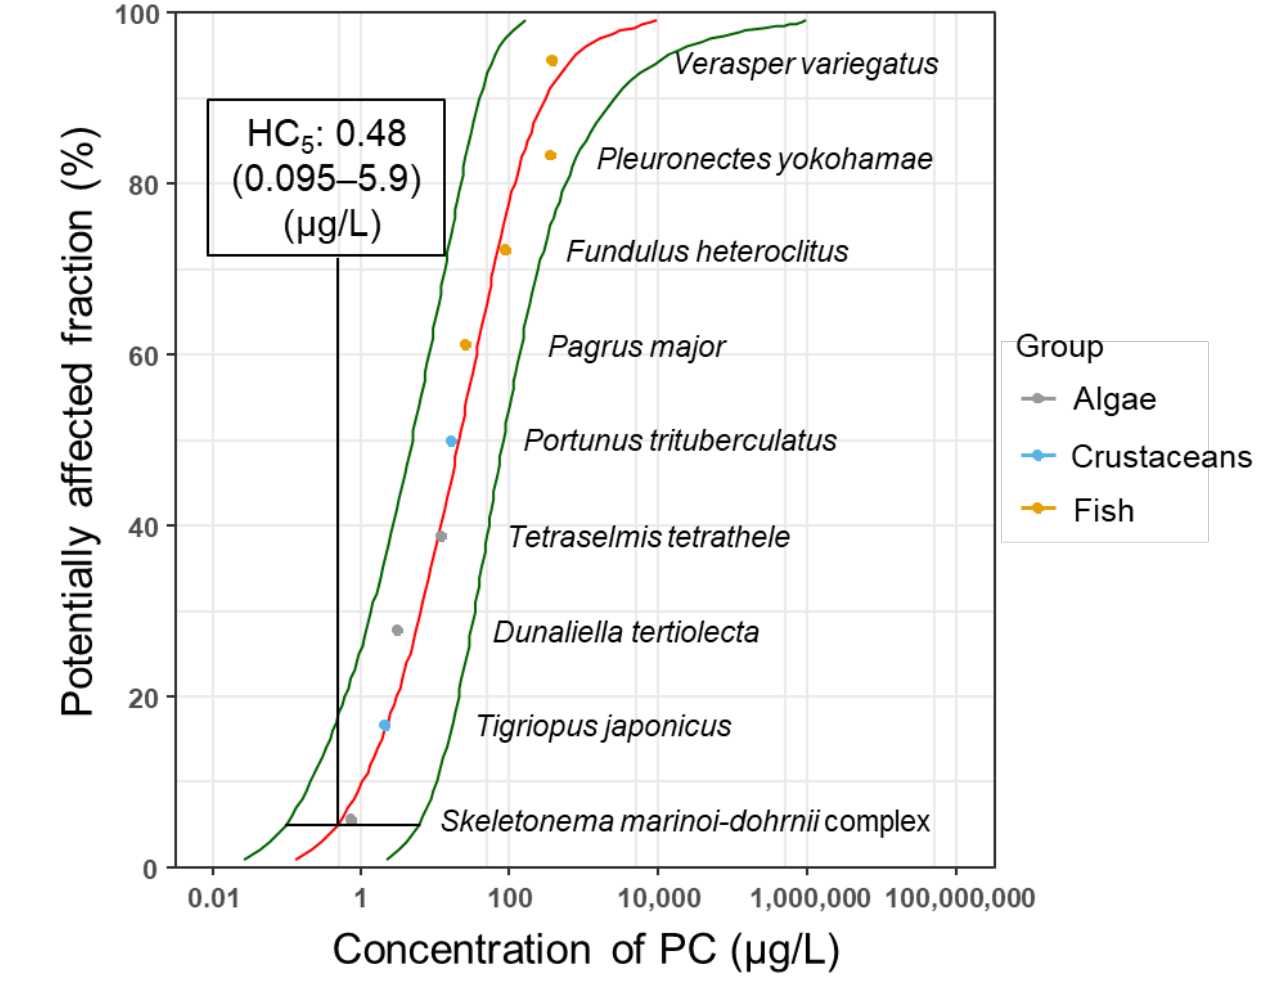
Figure 2. Species sensitivity distributions (SSDs) to polycarbamate (PC) derived from the model using the acute toxicity values (red line). The two green lines indicate the 95% confidence intervals. The positions of the 95% confidence interval of HC 5 are indicated by horizontal solid bars. The gray, blue, and orange circles represent the toxicity values for algae, crustaceans, and fish, respectively.